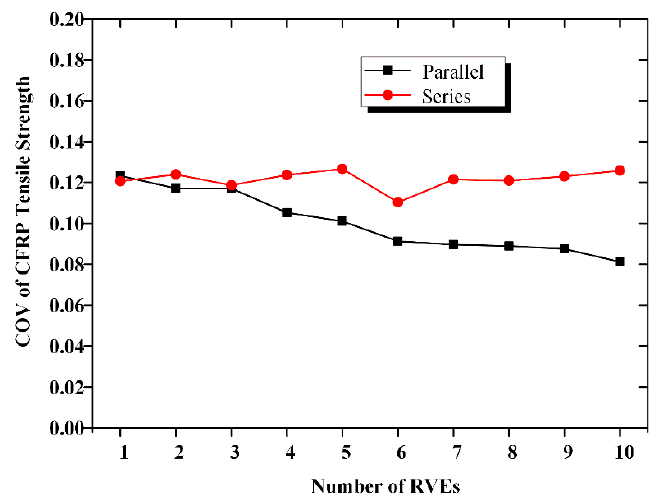
Figure 8. COV of CFRP strength.